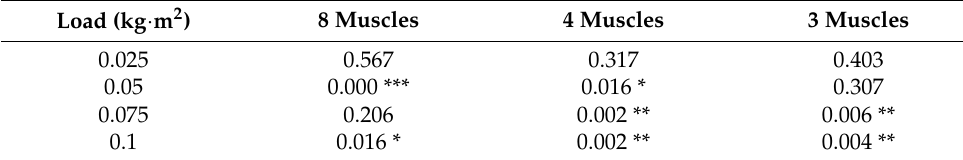
Table 4. p -values from sequential rank agreement (SRA) permutations tests